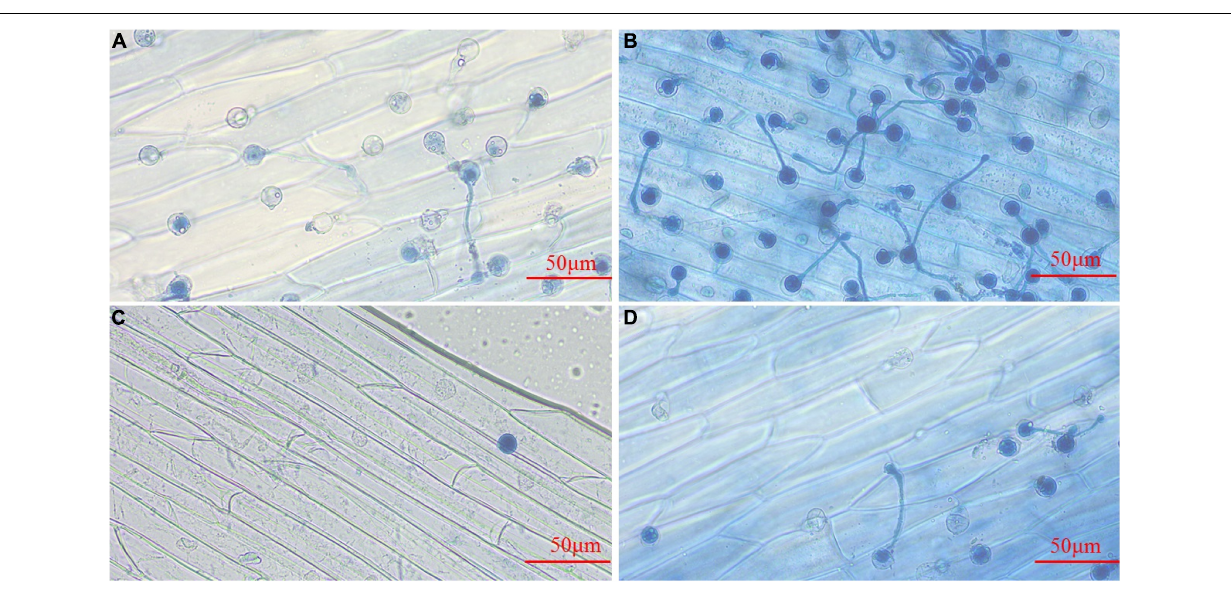
FIGURE 4 | Effect of 4-Ethylphenol on P. sojae zoospore invasion. Zoospore invasion after (A) 4 h of the control treatment (water), (B) 6 h of the control treatment (water), (C) 4 h of the 4-Ethylphenol treatment, (D) 6 h of the 4-Ethylphenol treatment. The control-treated P. sojae zoospores attached to the hypocotyls of yellow–yellow seedlings and grew many hyphae for infection, whereas the P. sojae treated with 4-Ethylphenol significantly reduced the adhesion and infection ability. The experiment was repeated three times, and similar results were